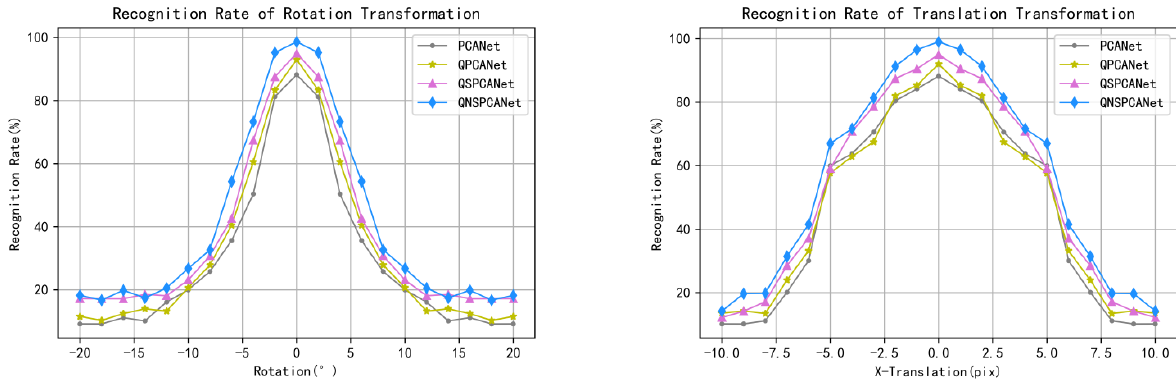
tional Figure 6. Four algorithms correctly identify rate curves under rotation transformation and transla- tional transformation.